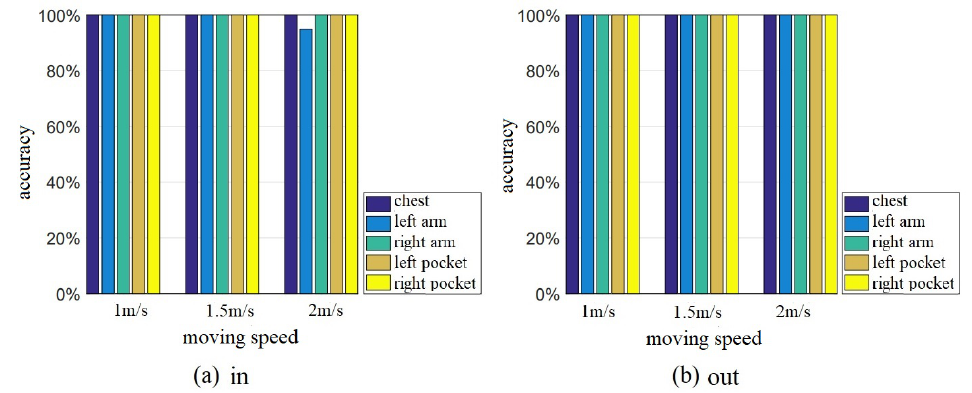
Figure 15. Detection accuracy of time-slot-based sensing model.